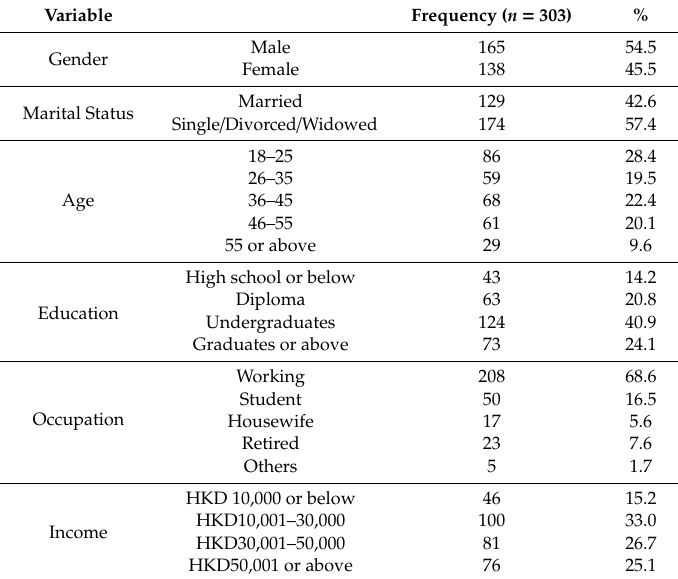
Table 1. The Demographic Profile of Participants.